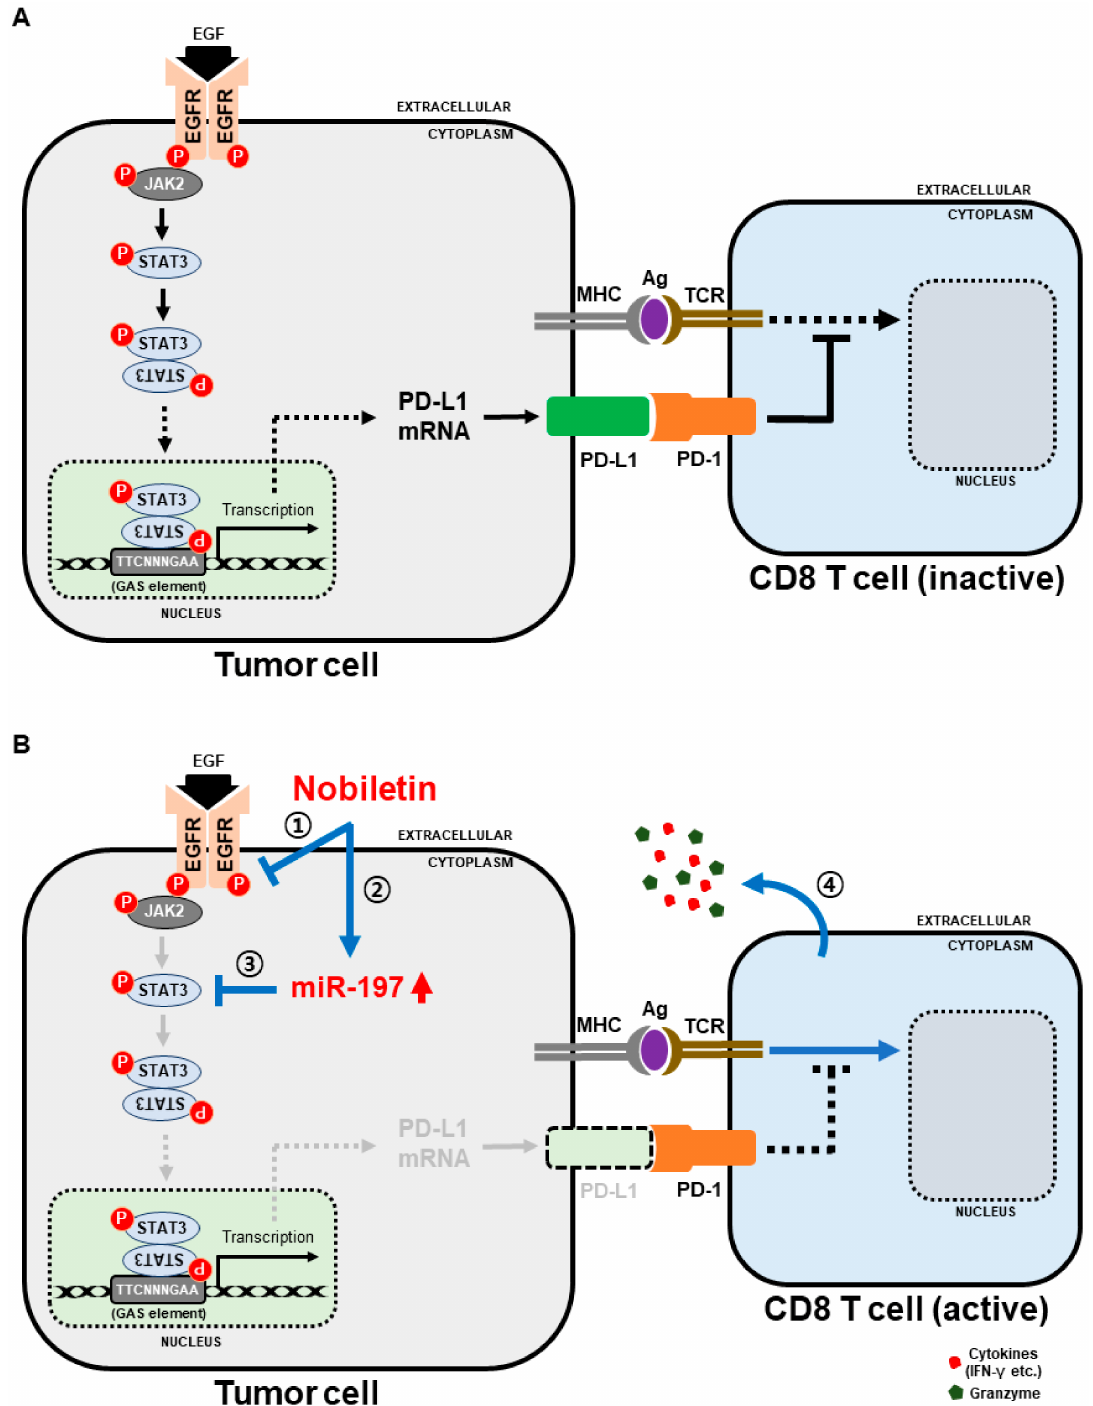
Figure 8. The molecular regulatory mechanism behind role of nobiletin in evasion of immunosuppression in NSCLC cells. ( A ) Tumor tolerance when PD-1/PD-L1 interaction. ( B ) Tumor clearance when the interaction is blocked.; 1 (cid:13) , 2 (cid:13) , and 3 (cid:13) Nobiletin inhibits the EGFR-mediated JAK2/STAT3 signaling pathway and thereby, PD-L1 inhibition through miR-197 regulation. 4 (cid:13) CD8 T cells sorted from PBMC induce NSCLC cell-apoptosis by secreting cytokines (IFN- γ , etc.) and